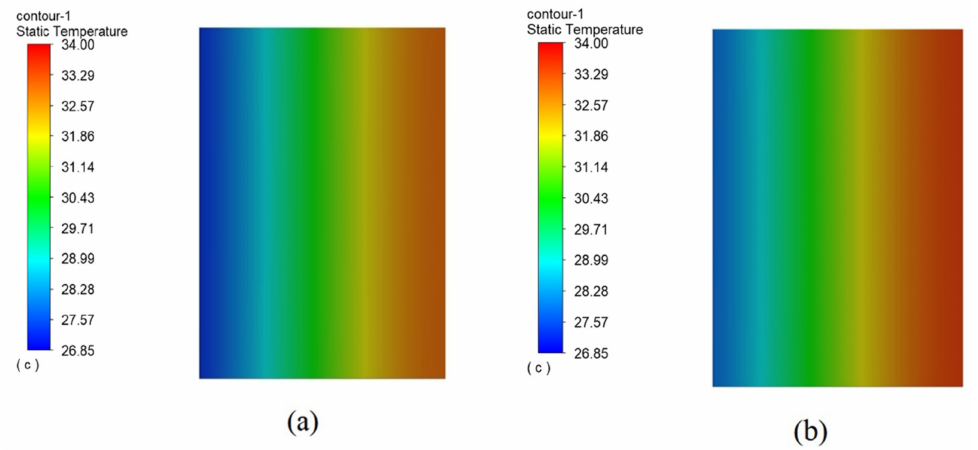
Figure 12. Temperature distributions of battery: ( a ) using AFHS with porosity-increasing gradient pattern m = 1, ( b ) using AFHS with porosity-decreasing gradient pattern m =